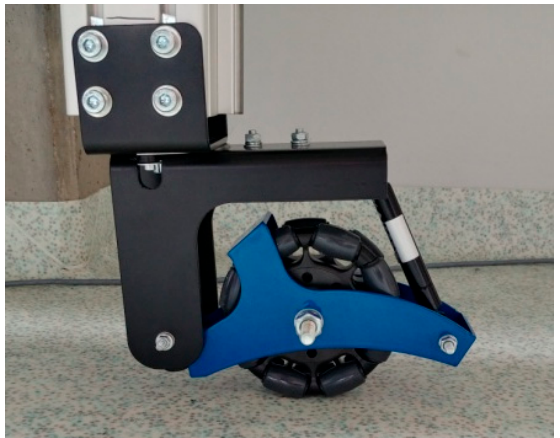
Figure 10. View of the vertical upright with the installed suspension system.